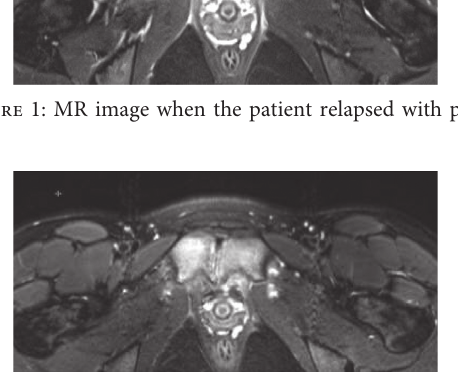
Figure 2: MRI after completion of therapy (about 6months